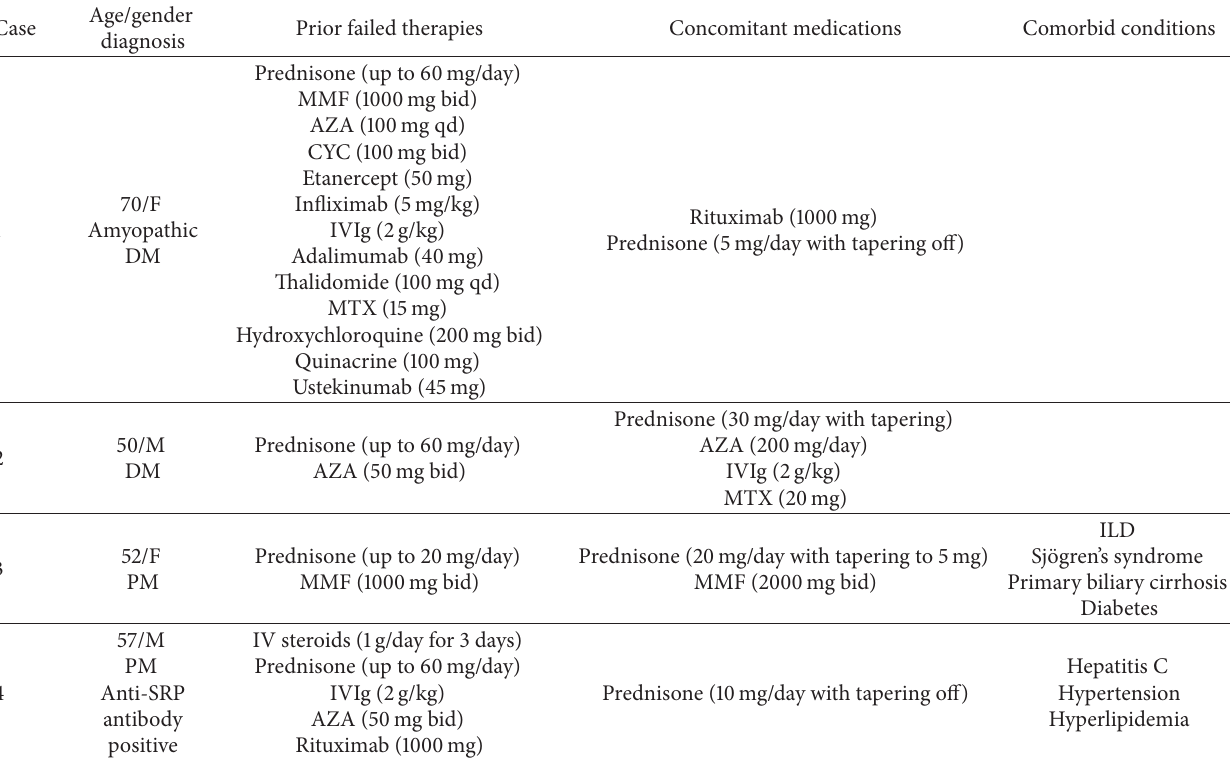
Table 1: Patient age at diagnosis, therapy prior to RCI, medications concomitant with RCI, and comorbid conditions.